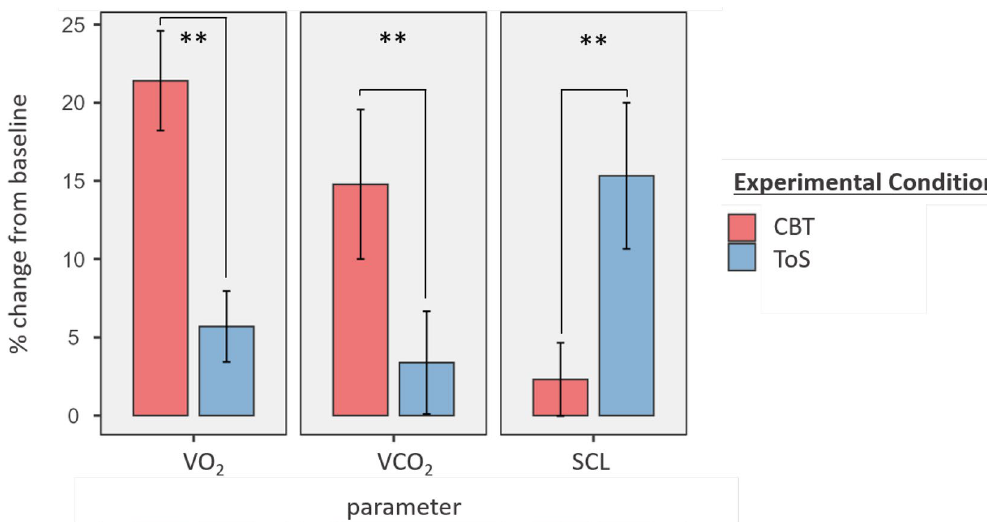
Figure 1. Responsiveness of physiological parameters (relative perspective). Note. Responsiveness corresponds to the parameter value change in percent when shifting from the baseline to the respective experimental condition. Except for VCO 2 , all mean comparisons between experimental conditions were significant. CBT = Corsi-Block-Tapping-Task; ToS = Threat-of-Shock; error bars indicate standard deviation.